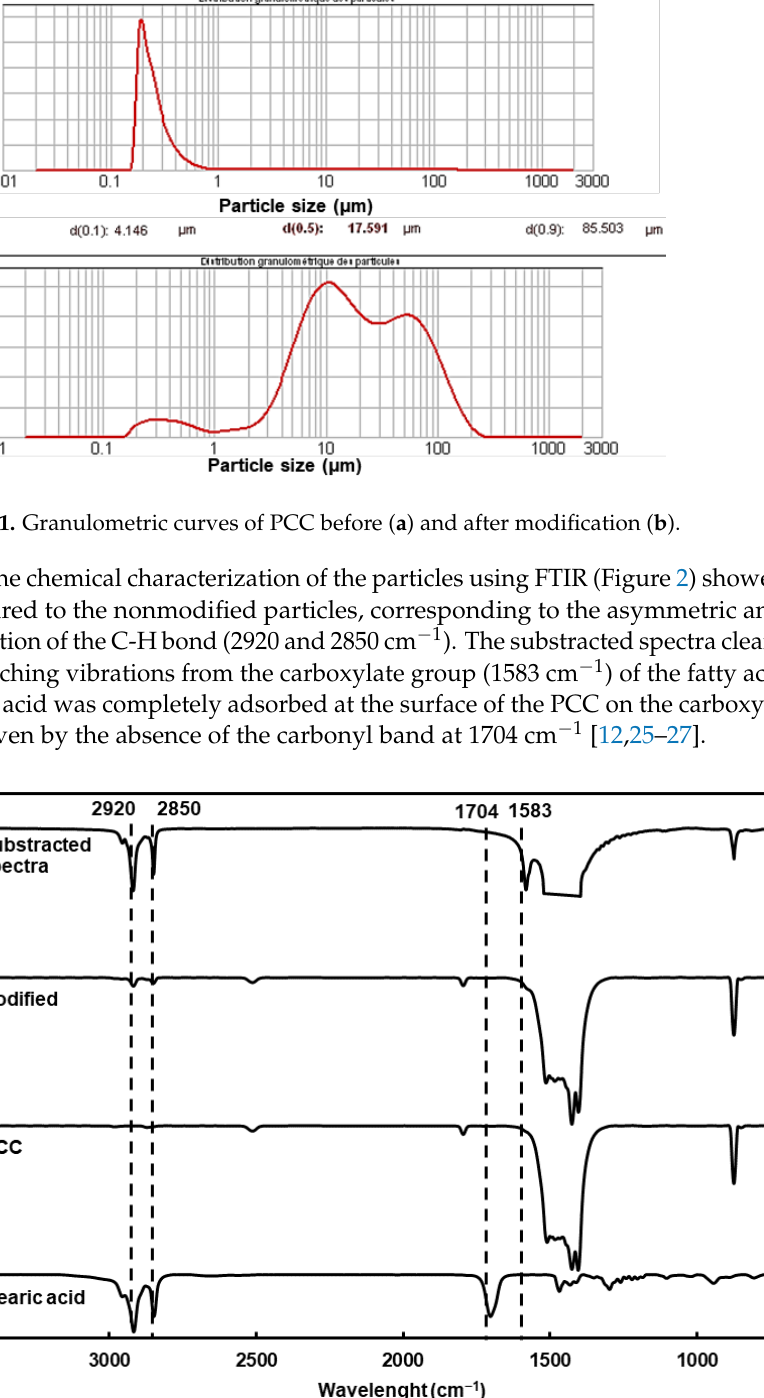
Figure 2. FTIR transmission spectra of modified PCC, stearic acid and PCC. The spectrum of modified PCC spectrum was substracted from PCC spectrum, but the band between 1400 and 1500 cm −1 was cut for clarity.